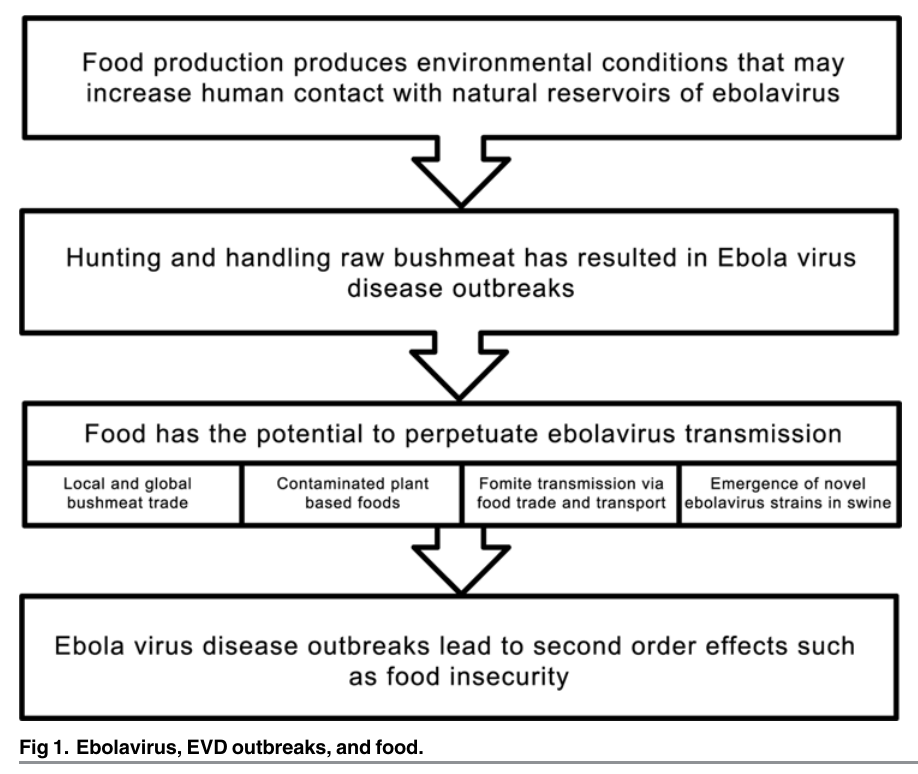
Fig 1. Ebolavirus, EVD outbreaks, and